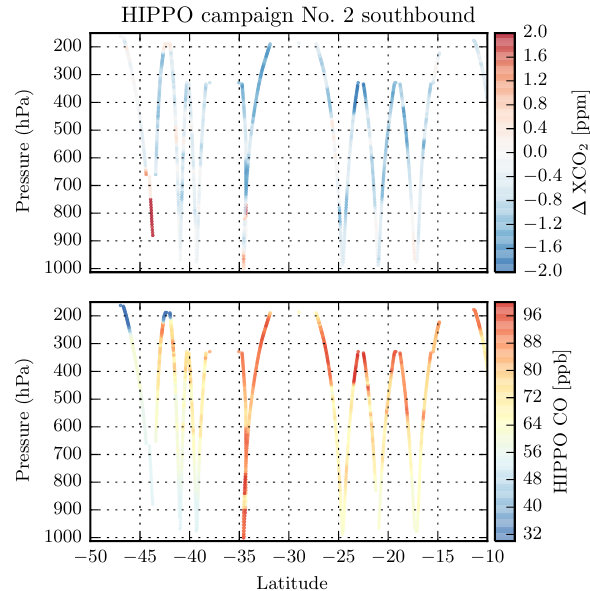
Figure 9. Top: MACC–HIPPO CO 2 differences (ppm) as a function of latitude and pressure level during the HIPPO 2 southbound cam- paign, recorded on 10–11 November 2009. Bottom: corresponding HIPPO CO measurements